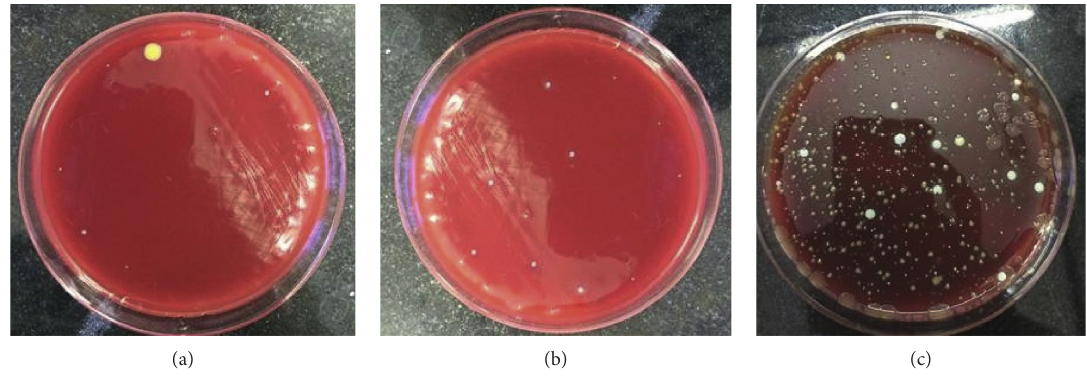
Figure 3: Blood agar plates: (a) group A; (b) group B; (c) group